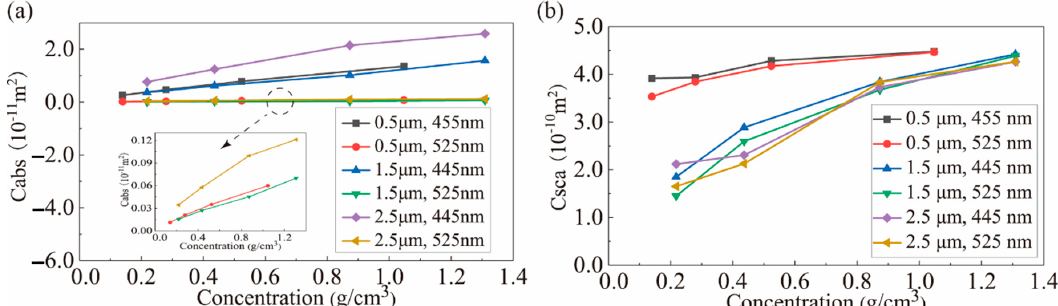
Figure 5. C abs and C sca for every multi-particle phosphor configuration. ( a ) C abs for different particle radii, concentrations, and source wavelengths. ( b ) C sca for different particle radii, concentrations, and source wavelengths.